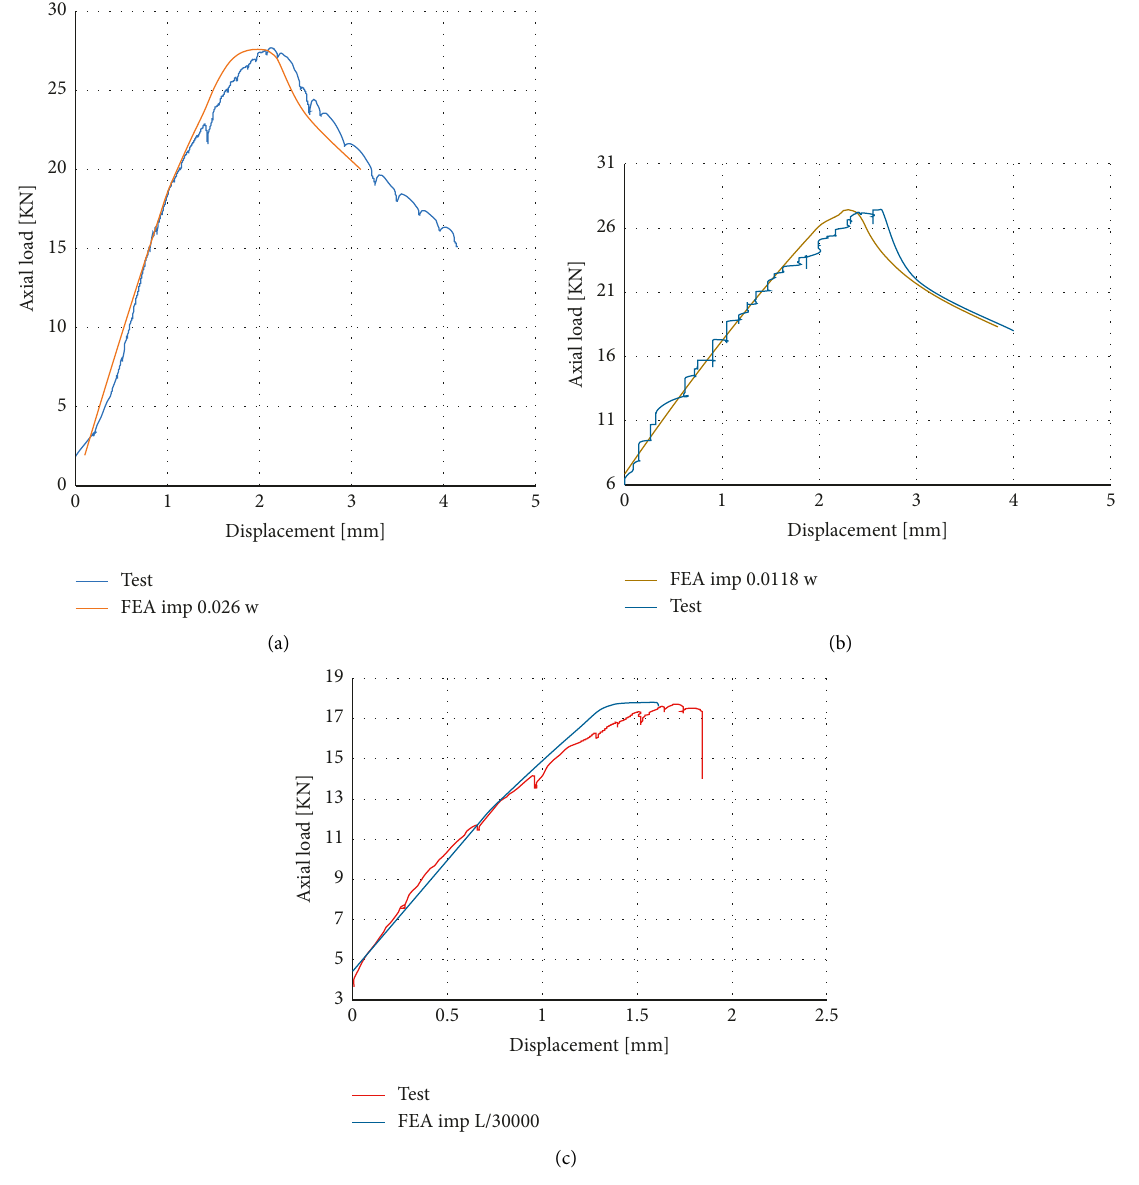
Figure 7: Experimental and numerical axial load-displacement curves of the: (a) 300mm column, (b) 600mm column, and (c) 2,000mm column.